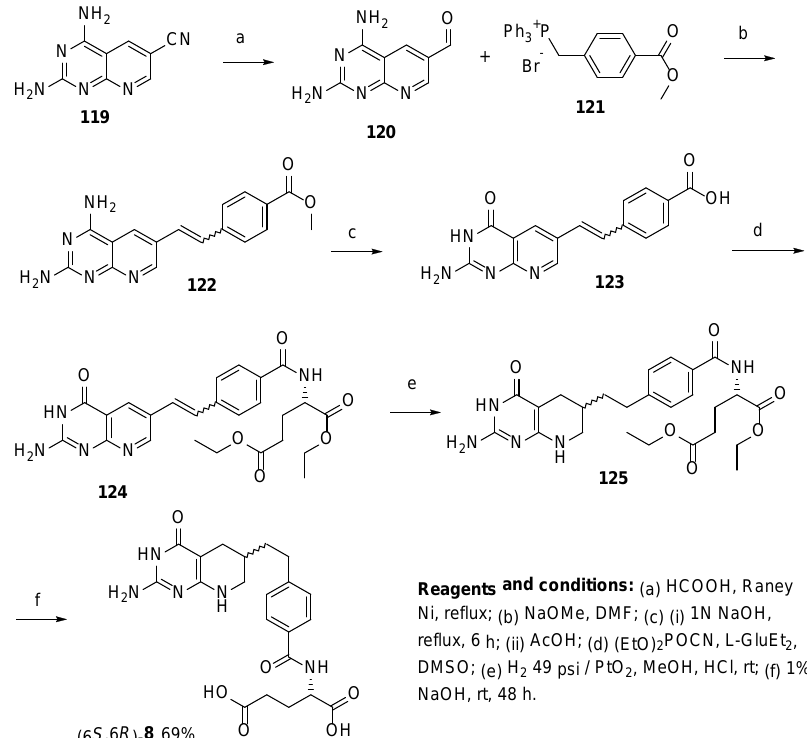
Scheme 34. Synthesis of (6 S ,6 R )-Lometrexol starting from 2,4-diaminopyrido[2,3- d ]pyrimidine-